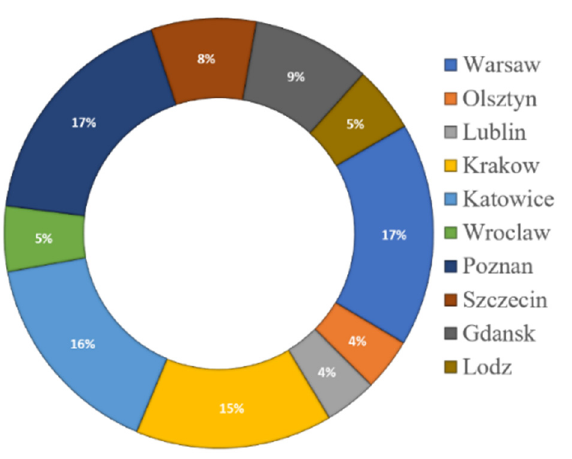
Figure 3. Share of each region in Poland in a comprehensive study to analyze energy consumption in the building sector [19].